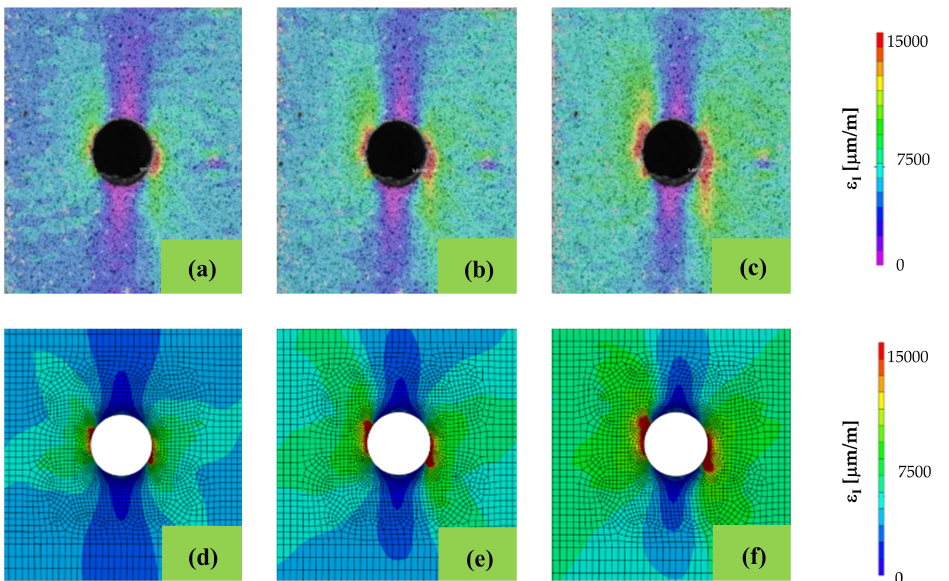
Figure 4. Comparison between the first principal strain ( ε I ) fields obtained experimentally and numerically. Images a, b and c correspond to the experimental results, and the remaining ones to the simulations with the application of Puck’s failure theory; the images ( a , d ), ( b , e ) and ( c , f ) correspond to loads of 4.3 kN, 4.875 kN and 5.5 kN, respectively.